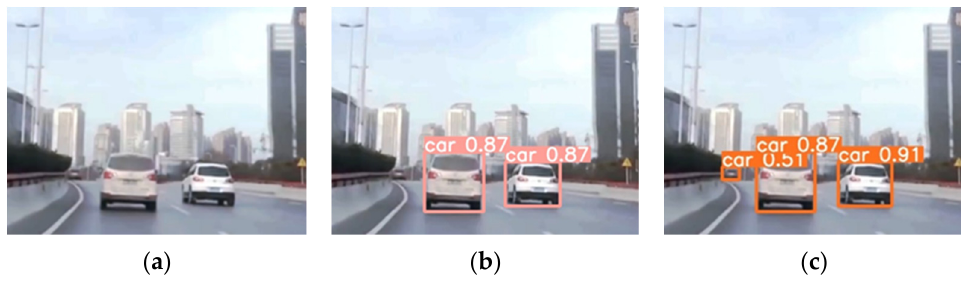
Figure 12. Visualization comparison before and after CBAM function improvement.